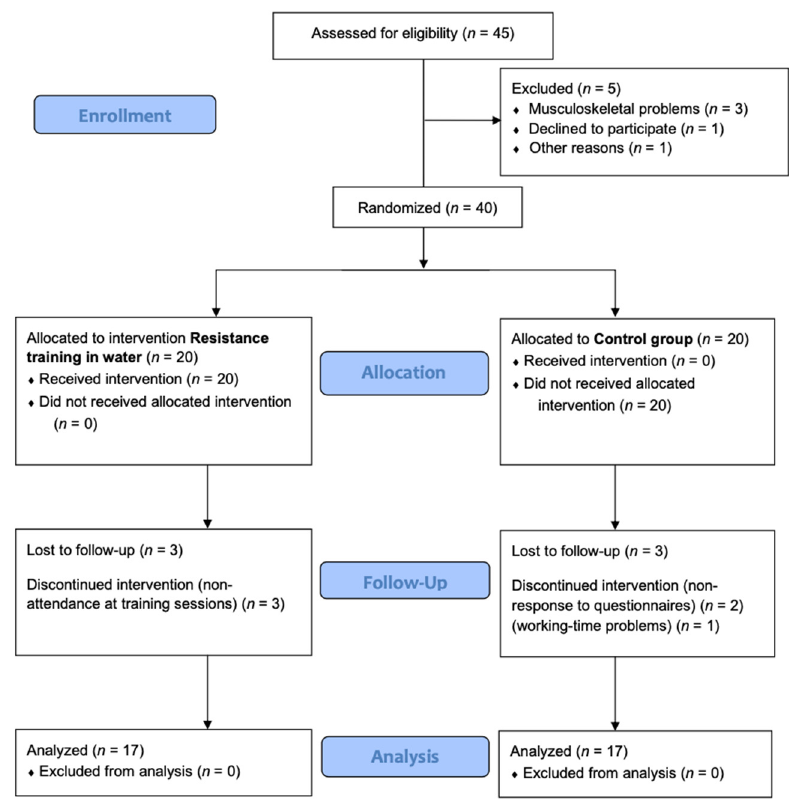
Figure 1. Consort 2010 flow diagram.